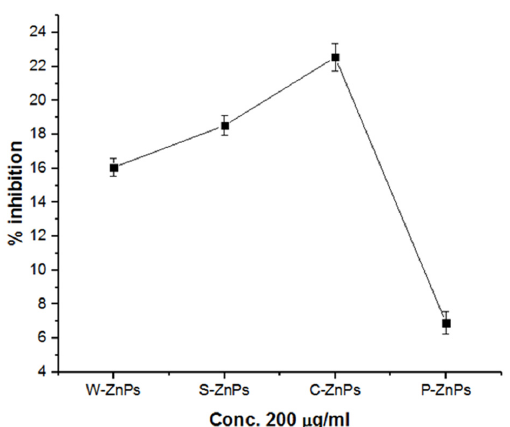
Figure 7. ZnO NPs induced % inhibition of α -amylase. The experiments were carried out in triplicate. The values given in figure are mean ± standard deviation of the original data.